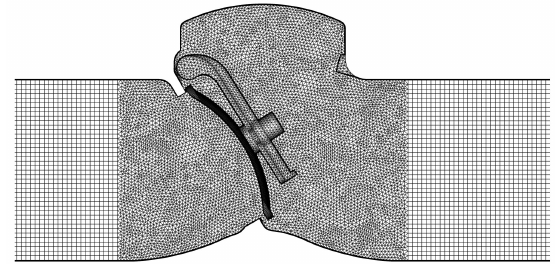
Figure 2. Grid of the swing check valve.